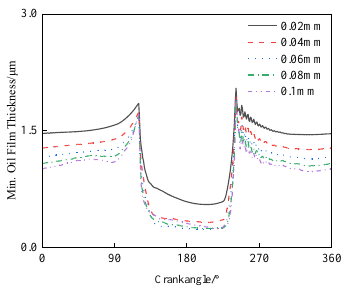
Figure 12. MOFT at different clearances.